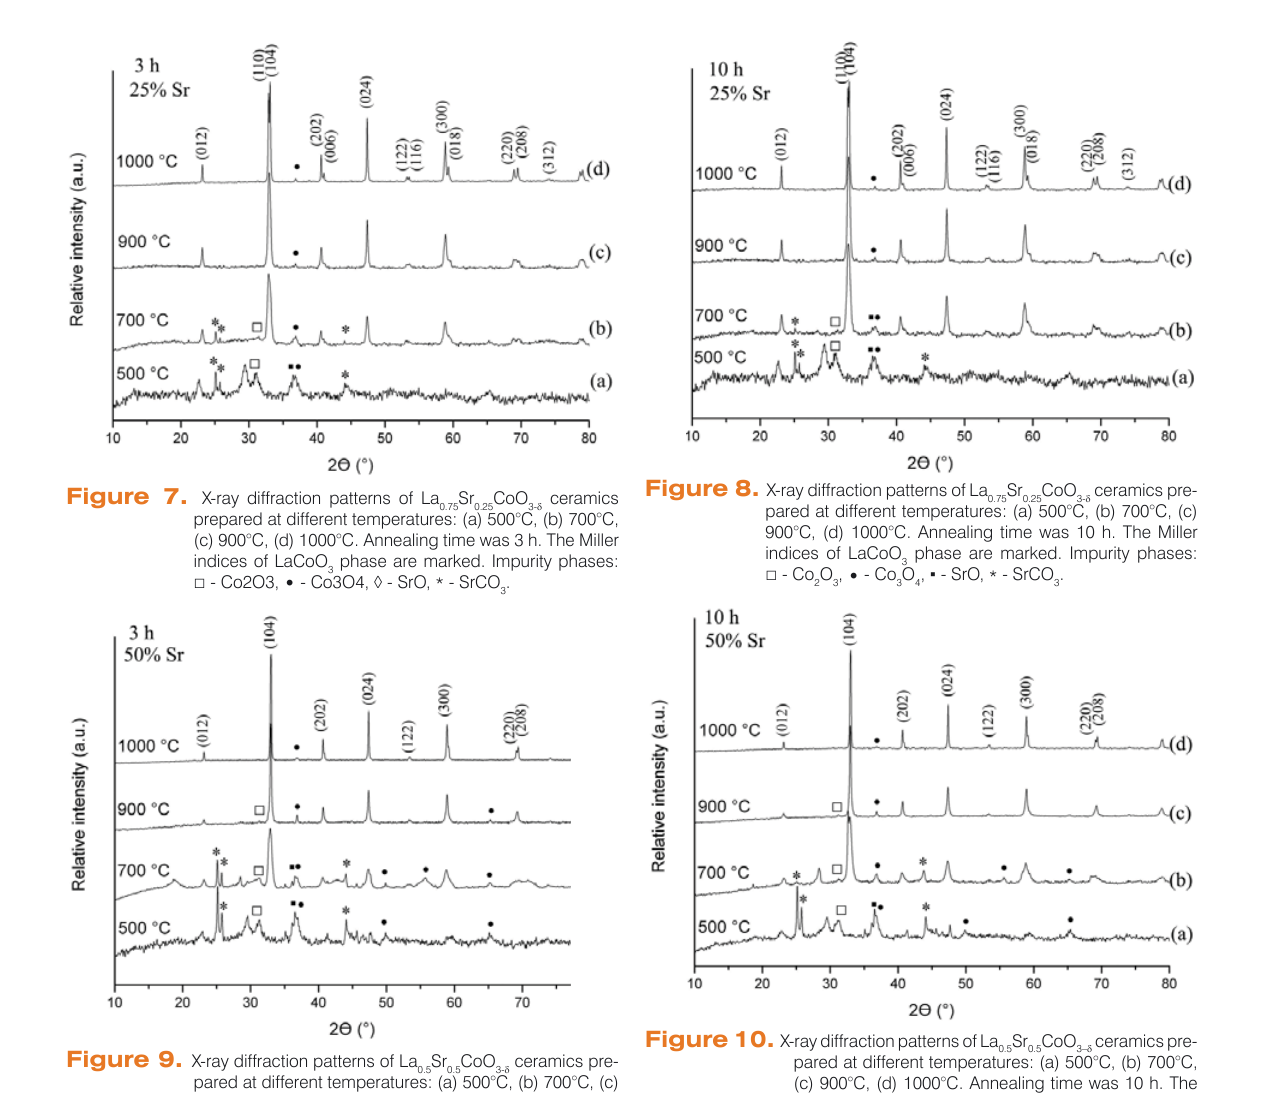
pared at different temperatures: (a) 500°C, (b) 700°C, (c) 900°C, (d) 1000°C. Annealing time was 10 h. The Miller indices of LaCoO phases: □ - Co